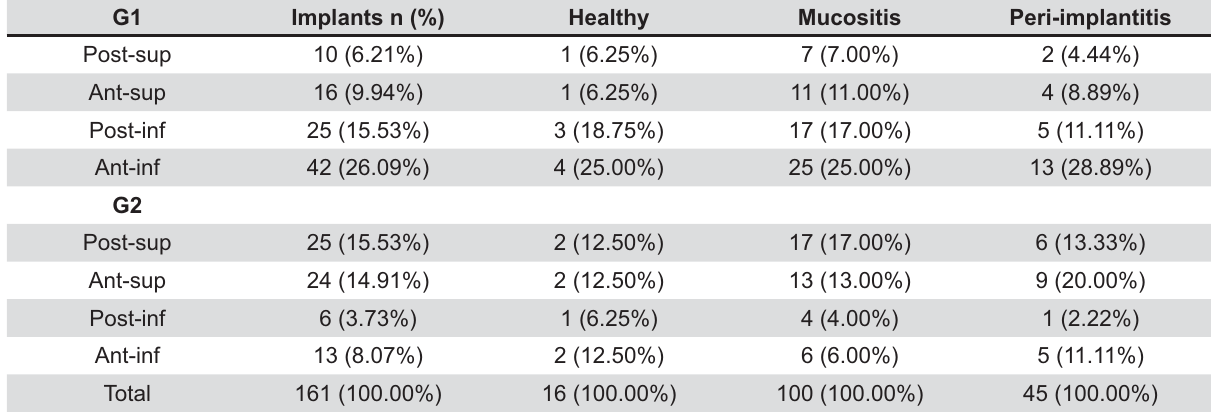
Table 1- Frequency and distribution of data on the G1 implants (up to 5 implants) and G2 (more than 5 implants) according the implant placement